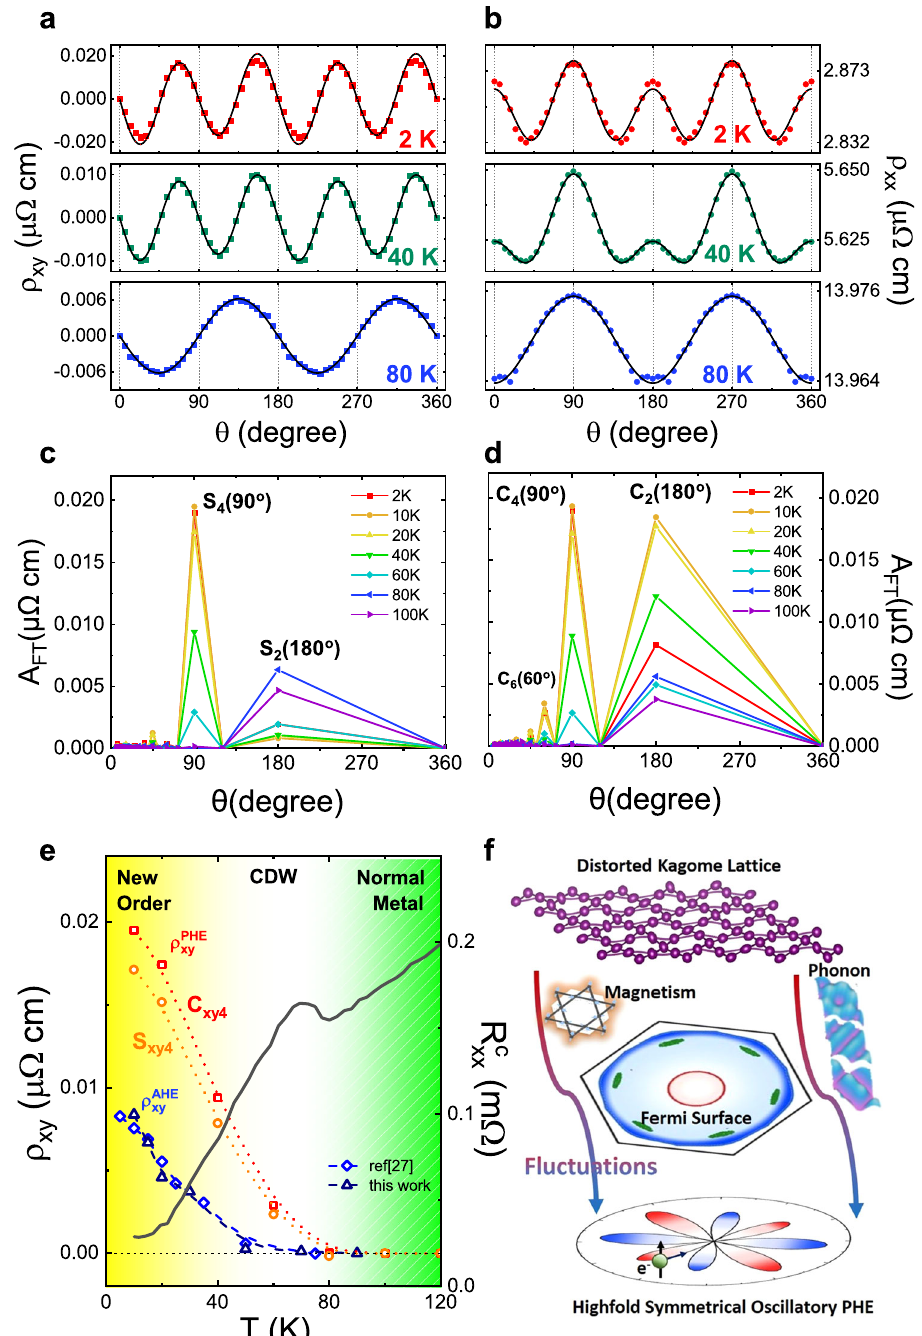
Fig. 4 The phase diagram for evolved high-order components of PHE and PAMR. a , b The typical ρ xy ( θ ) and ρ xx ( θ ) with μ 0 H = 14 T at 2, 40, and 80 K. The fi tting curves are marked by black solid lines. c , d The FFT spectrum of ρ xy ( θ ) and ρ xx ( θ ) with μ 0 H = 14 T at 2, 10, 20, 40, 60, 80, and 100 K, respectively. e The temperature dependent anomalous Hall resistivity ρ AHE xy for two samples are shown with the left axis. The data of black line are acquired from our measurements and the data of blue line are acquired from ref. 27 . The temperature dependent S xy 4 and C xx 4 for ρ xy are also shown with the left axis. The temperature dependent resistance along c axis R c xx is shown with the right axis with a prominent CDW anomaly around 78 K . f The schematic for the coupling between distorted lattice and Fermi surface leading to high symmetrical oscillatory PHE driven by an in-plane fi